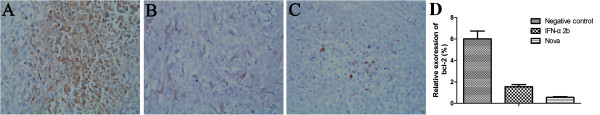
The immuno histochemical analysis result of Bcl-2 in each group. Bcl-2 protein decreased in tumor tissues after mice was treated by IFN-α2b (B) and Nova (C) compared with the negative control (A). D is quantization of the expression of the proteins evaluated in the different samples with immunohistochemistry.